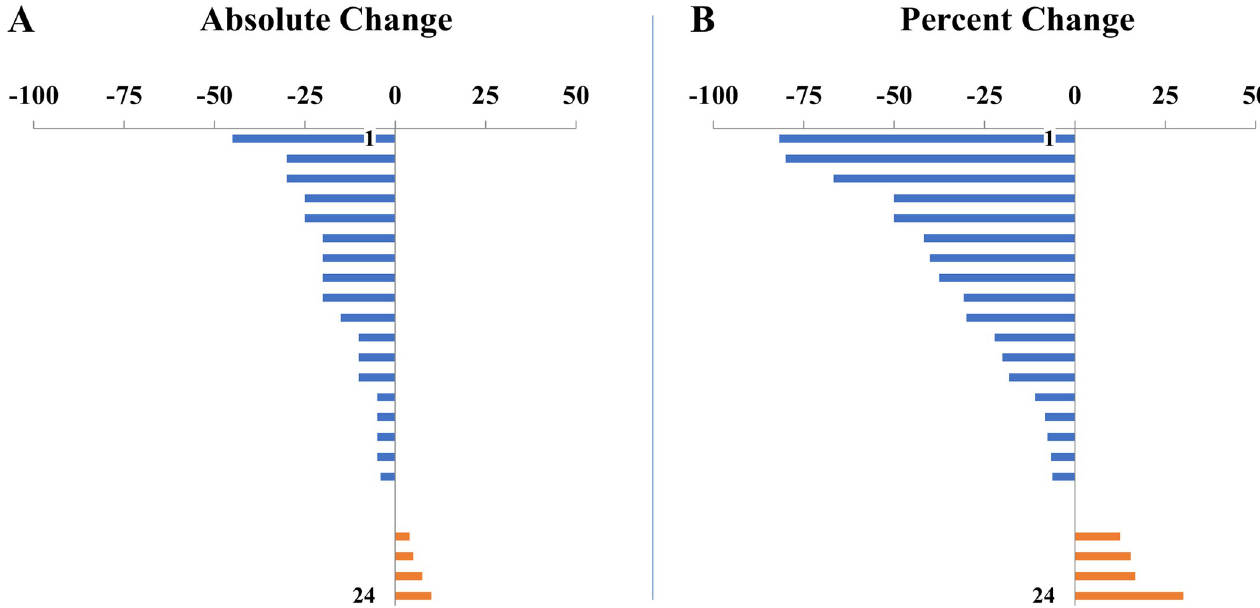
Fig 4. Total treatment response to tACS. (A) Absolute change and (B) Percent change in symptoms after 10–12 sessions of the tACS paradigm of the participant’s choice. Scores were calculated based on a 0–100 Visual Analogue Scale in which lower values represent lower symptom severity.